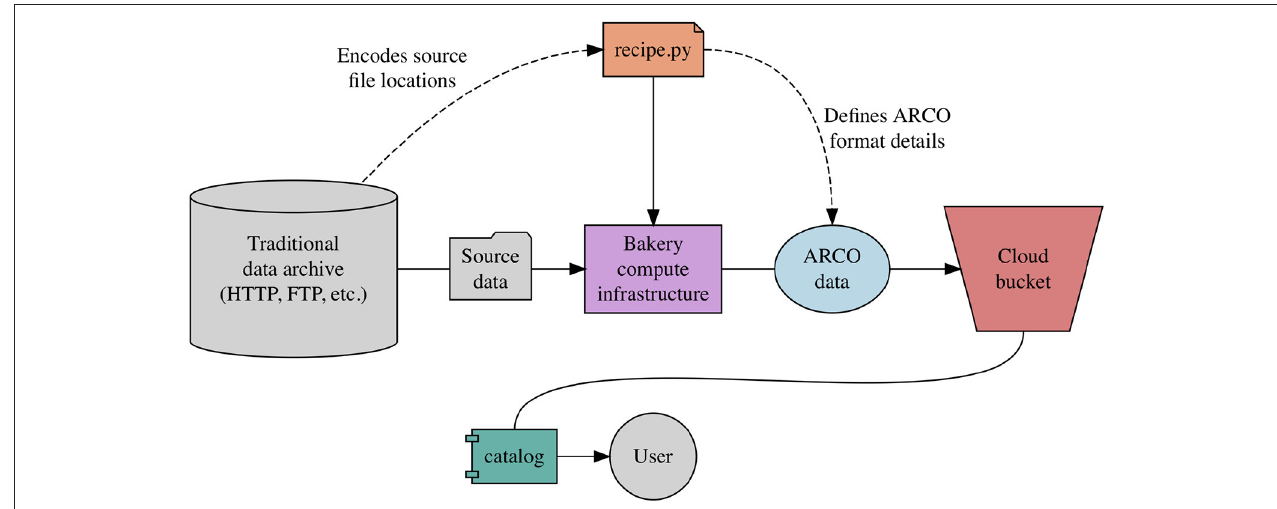
FIGURE 2 | A recipe in relation to Pangeo Forge